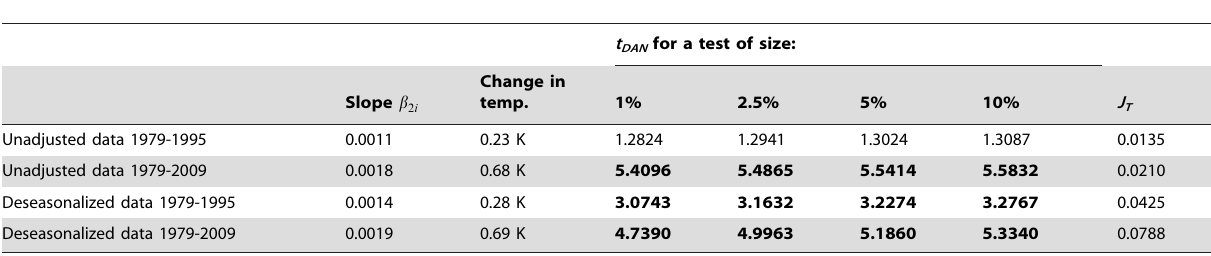
Table 3. t DAN Trend Tests for Omumbo et al . Kericho Temperature Series.